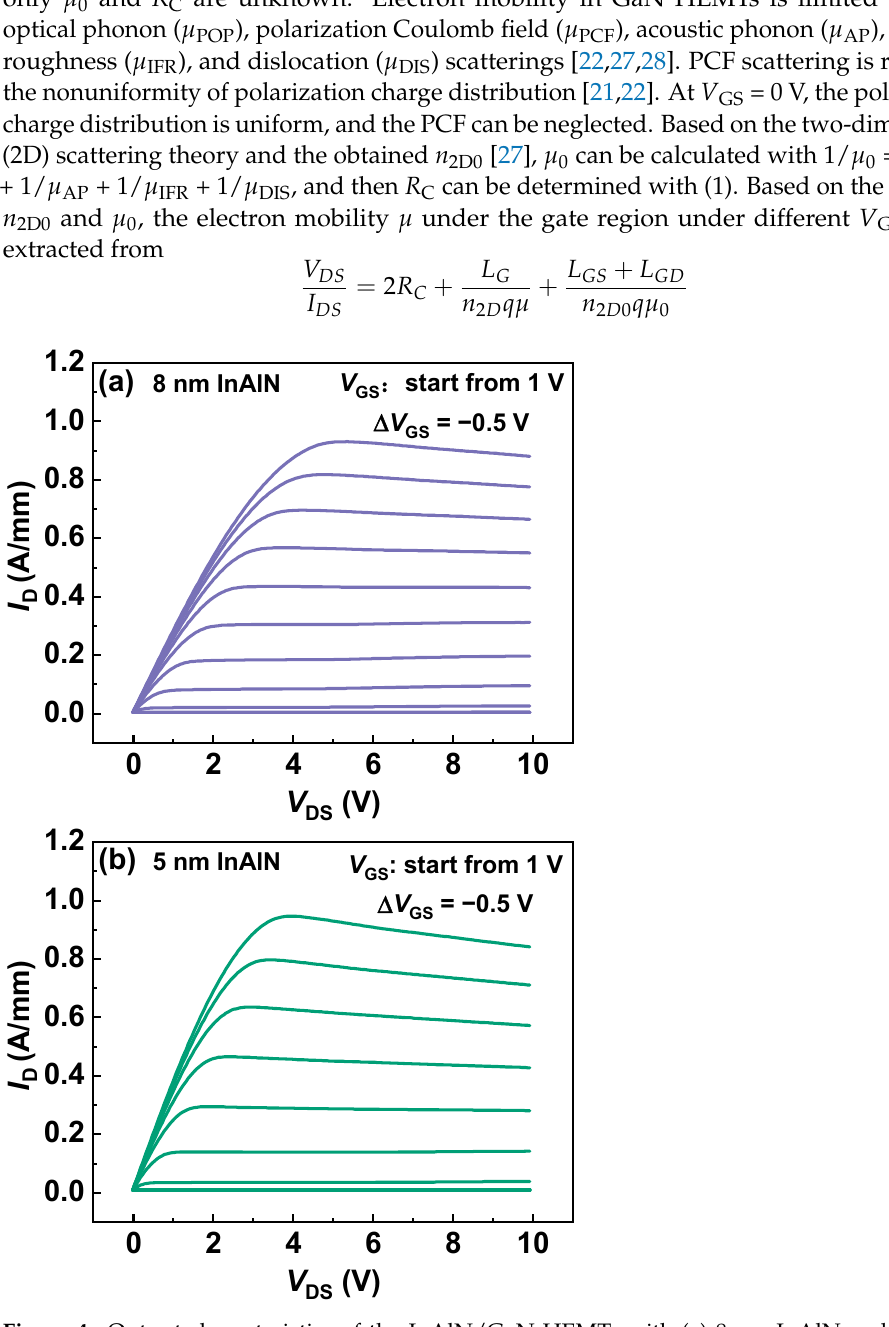
Figure 4. Output characteristics of the InAlN/GaN HEMTs with ( a ) 8 nm InAlN and ( b ) 5 nm InAlN, respectively.